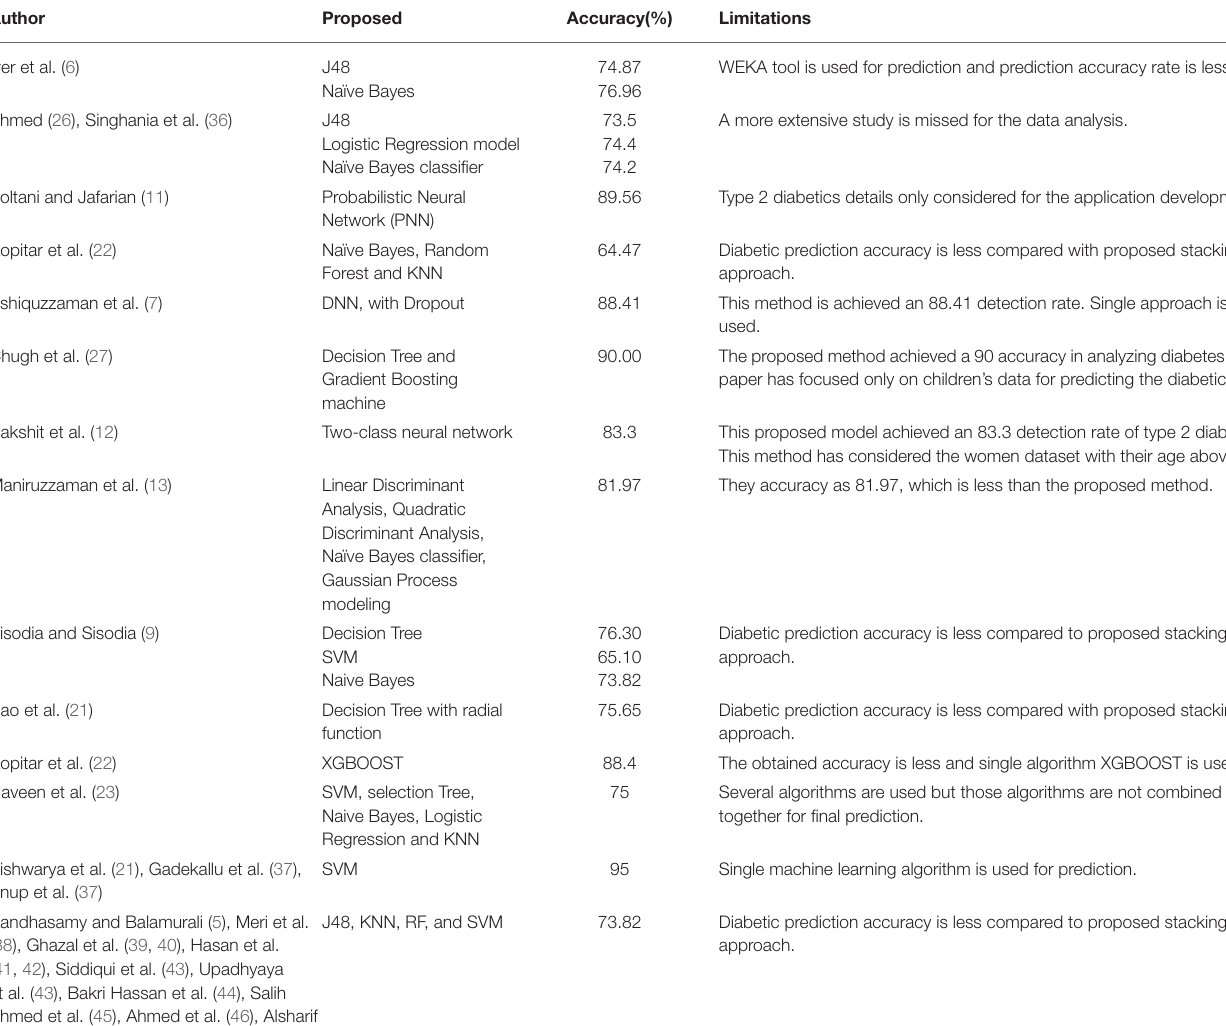
TABLE 1 | Summary of the existing